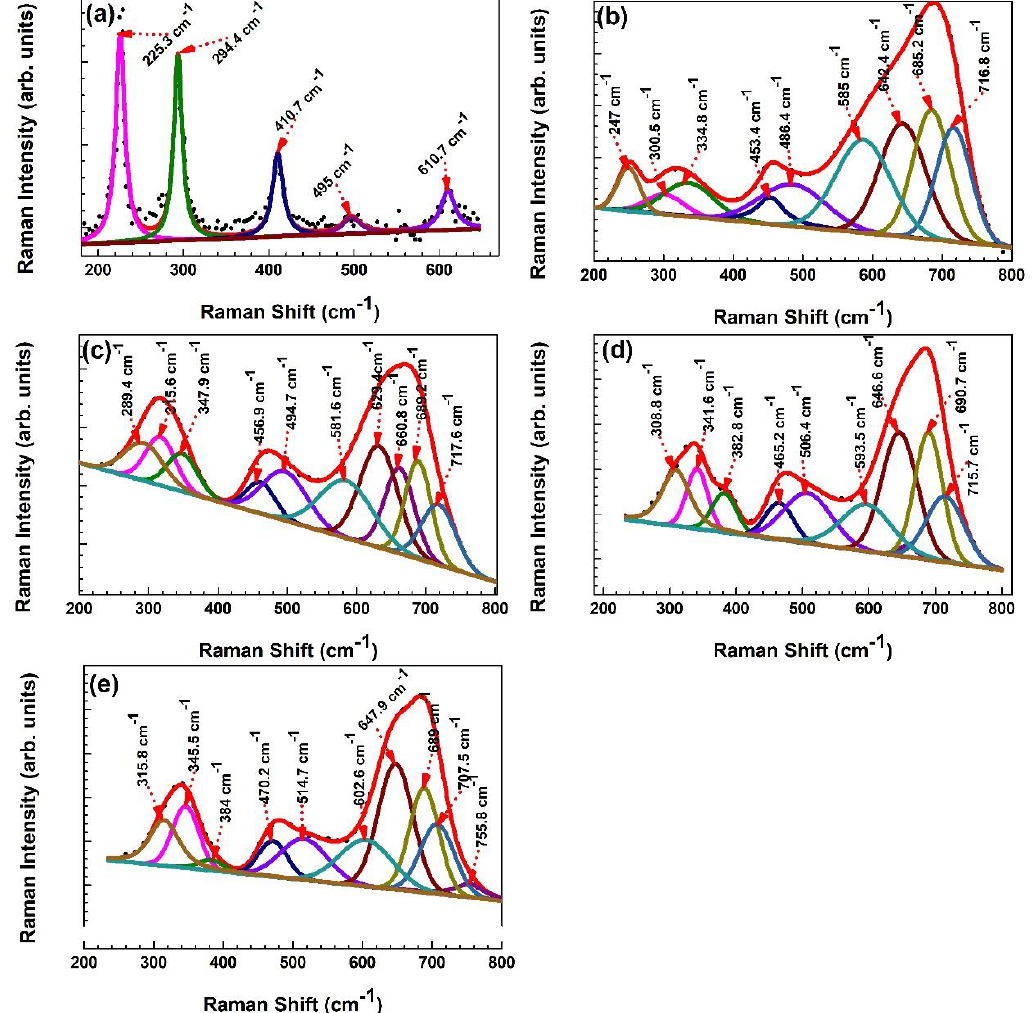
Figure 8. Raman spectra of: ( a ) pure Fe 2 O 3 and doped with Zn; ( b ) 1%; ( c ) 3%; ( d ) 5%; and ( e ) 7%, respectively.